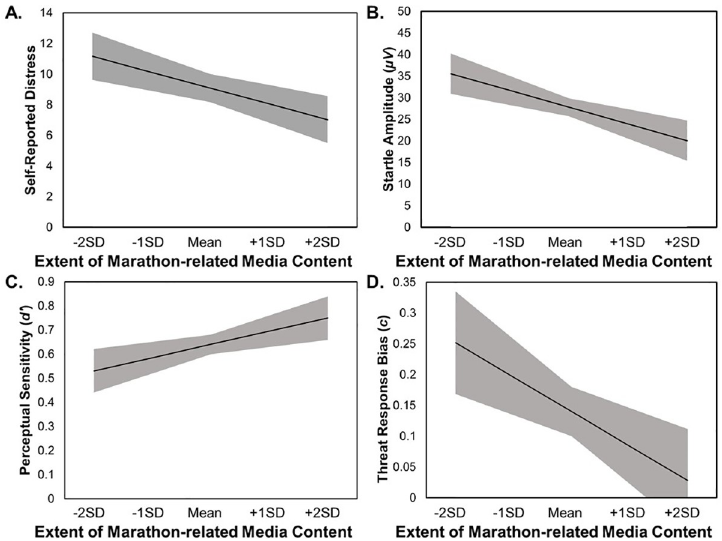
Fig 2. Simple slopes representation of models predicting changes in distress (Panel A), startle reactivity (Panel B), perceptual sensitivity (Panel C), and Threat response bias (Panel D) by changes in the extent of recent marathon-related coverage. Extent of recent marathon-related media coverage was calculated to be time-locked for each participant at each Wave to include only media coverage from the two weeks prior to that participant’s laboratory visit. Model slopes are represented by a black line, with ± 1 standard error of the slope and intercept for each model shown as a gray-shaded area. SD stands for standard deviation. The model for perceptual sensitivity (Panel C) is plotted at the within-person mean for threat response bias, and the model for threat response bias (Panel D) is plotted at the within-person mean for perceptual